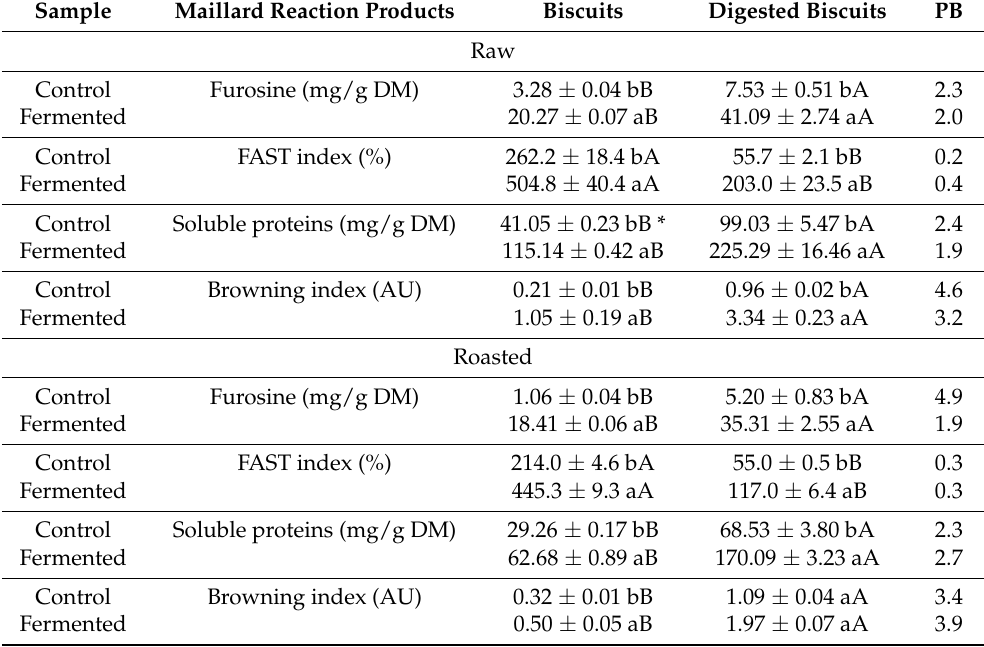
Table 1. The Maillard reaction products and their potential bioaccessibility in biscuits from raw and roasted buckwheat before and after in vitro